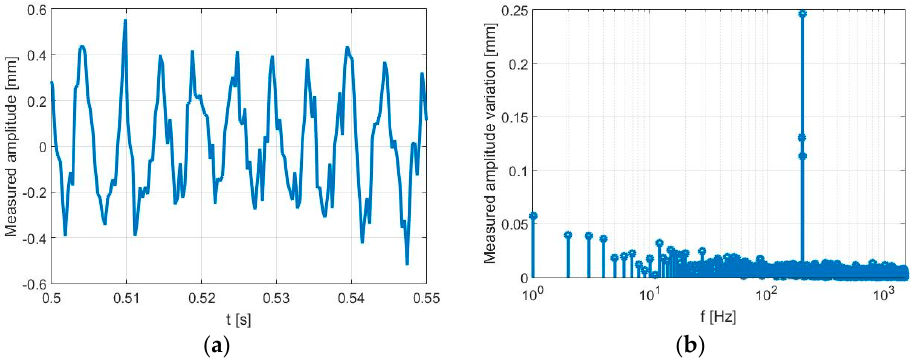
Figure 11. Captured scene in the presence of an oscillating target: ( a ) time domain; ( b ) frequency domain.